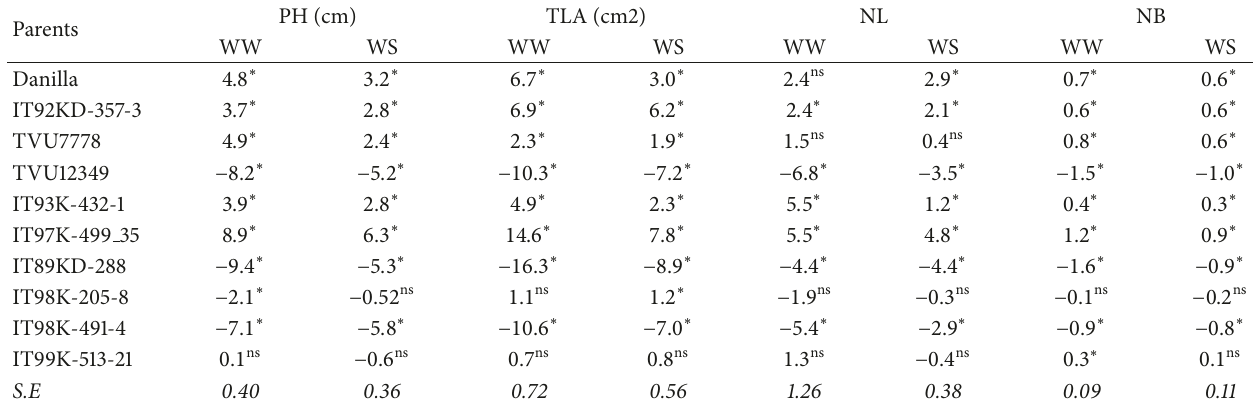
Table 3: General combining ability effects of morphological characteristics of ten cowpea genotypes in water-stressed (WS) and well-watered (WW)